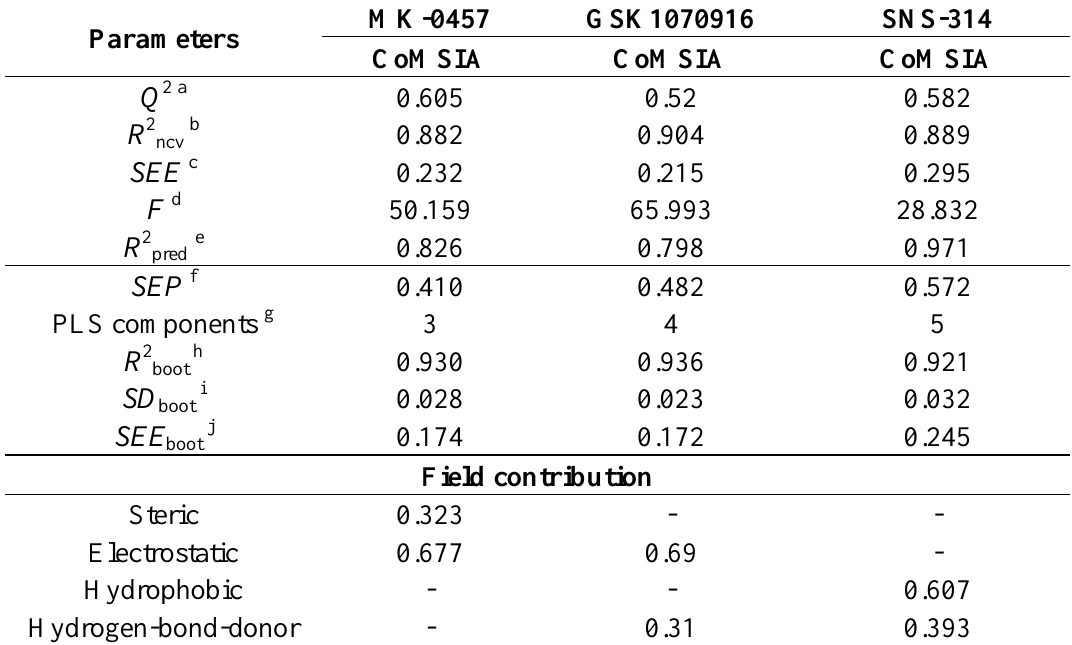
Table 4. Summary of statistics and field contributions for the top model of each